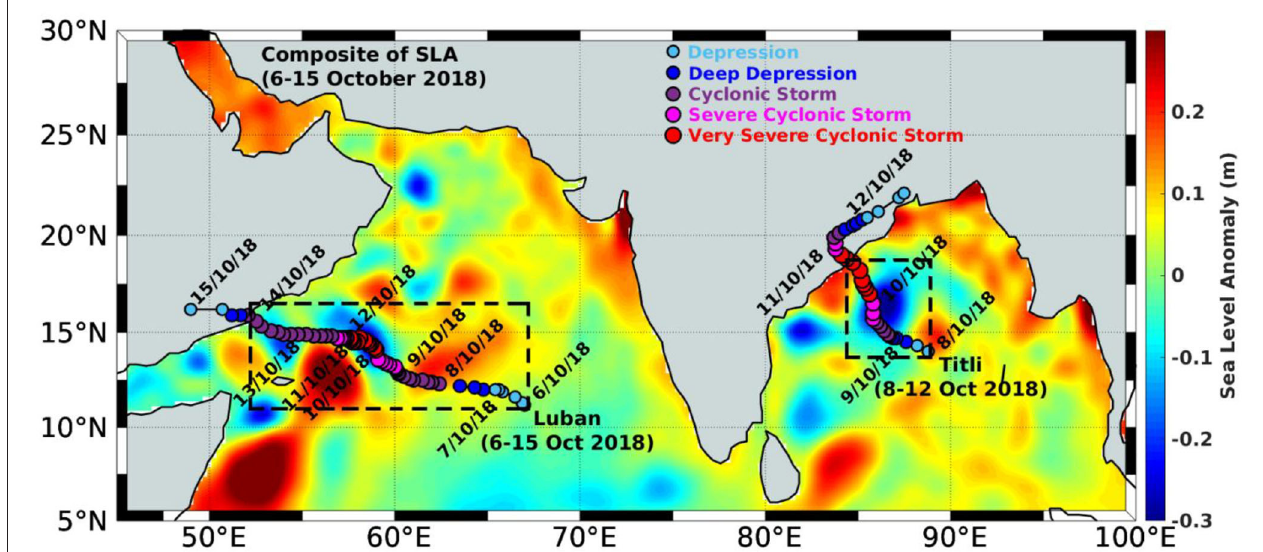
FIGURE 1 | A map showing the North Indian Ocean comprising of the Arabian Sea (AS) and the Bay of Bengal (BoB) with tracks of the cyclones Luban and Titli denoted by the filled circles with different color markers to show the different stages of the cyclone (a cyan circle for depression, a blue circle for deep depression, a purple circle for cyclonic storm, a magenta circle for severe cyclonic storm, and a red circle for very severe cyclonic storm). Shading is the sea level anomaly (SLA) (m). The boxes with broken black lines are the regions that were used for the computation of various parameters. See text for details.